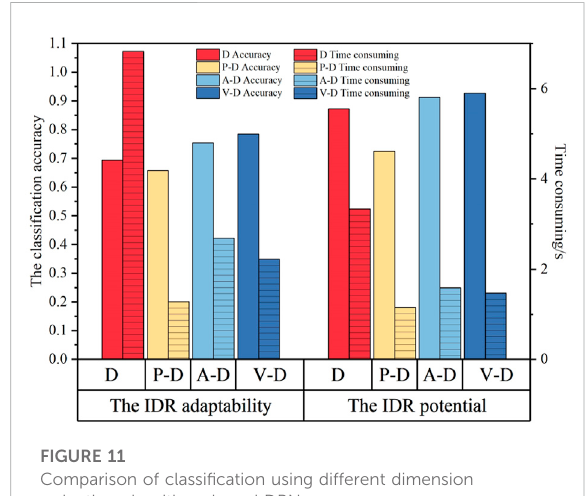
FIGURE 11 Comparison of classi fi cation using different dimension reduction algorithms based